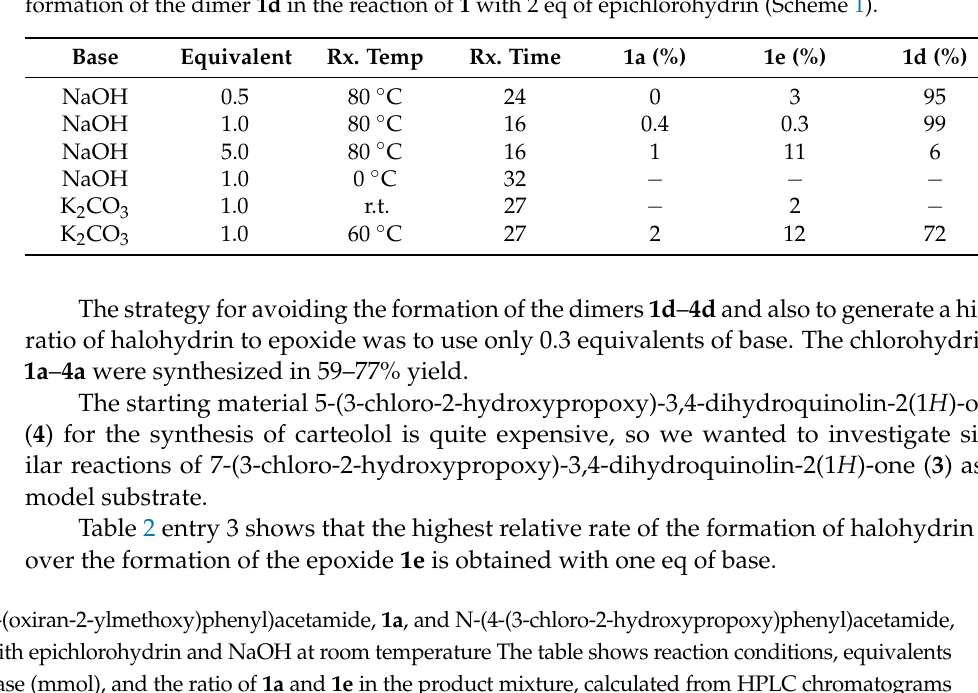
Table 1. A reaction temperature of 80 ◦ C and 0.5–1.0 eq of NaOH dissolved in water favored the formation of the dimer 1d in the reaction of 1 with 2 eq of epichlorohydrin (Scheme 1).